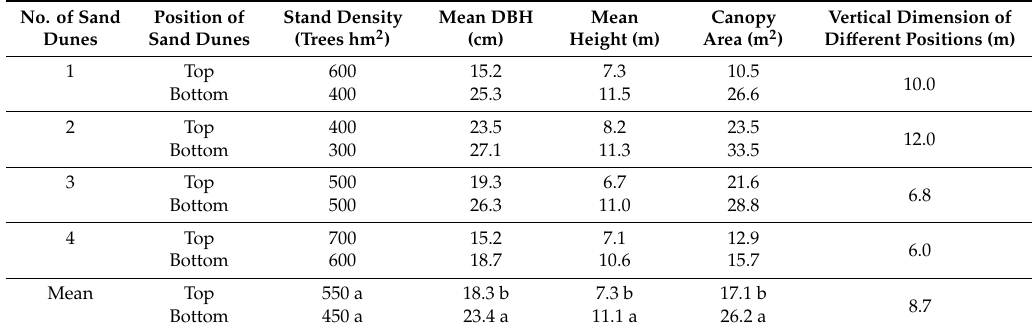
Table 1. Characteristics of the Mongolian pine plantations at the top and bottom of selected sand dunes in the study region. Different letters indicate significant differences between the top and bottom of sand dunes.